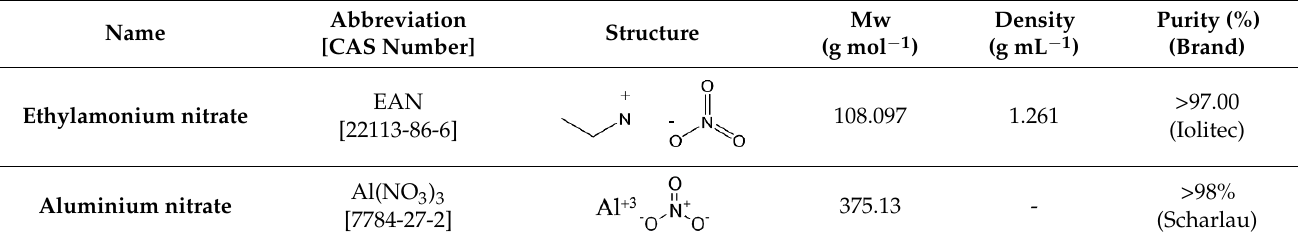
Table 1. Characteristics of ethylammonium nitrate and aluminium nitrate.